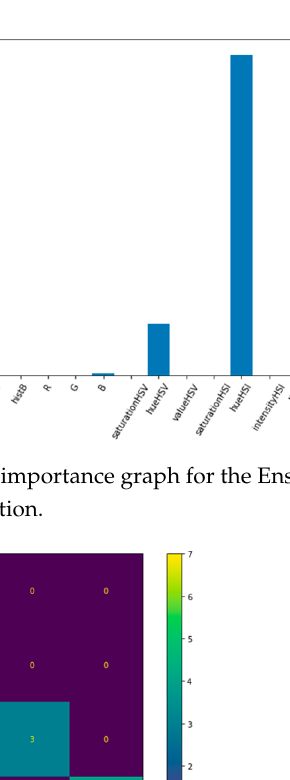
Figure 11. Confusion matrix of tuna sample prediction performed by Ensemble.